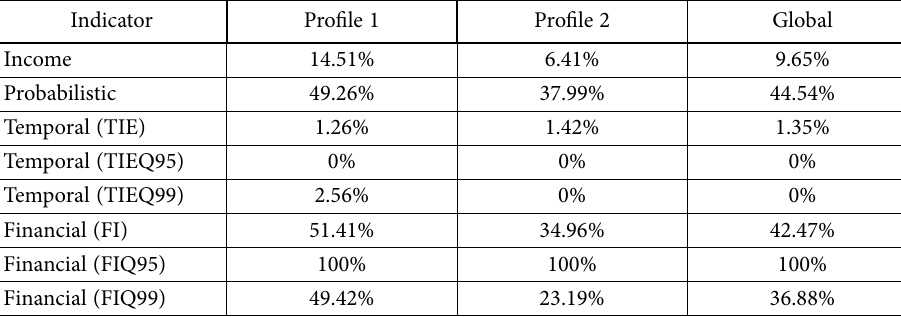
Table 8. Impact indicators (source: own elaboration) Indicator Profile 1 Profile 2 Global 14.51% 6.41% 9.65% 49.26%